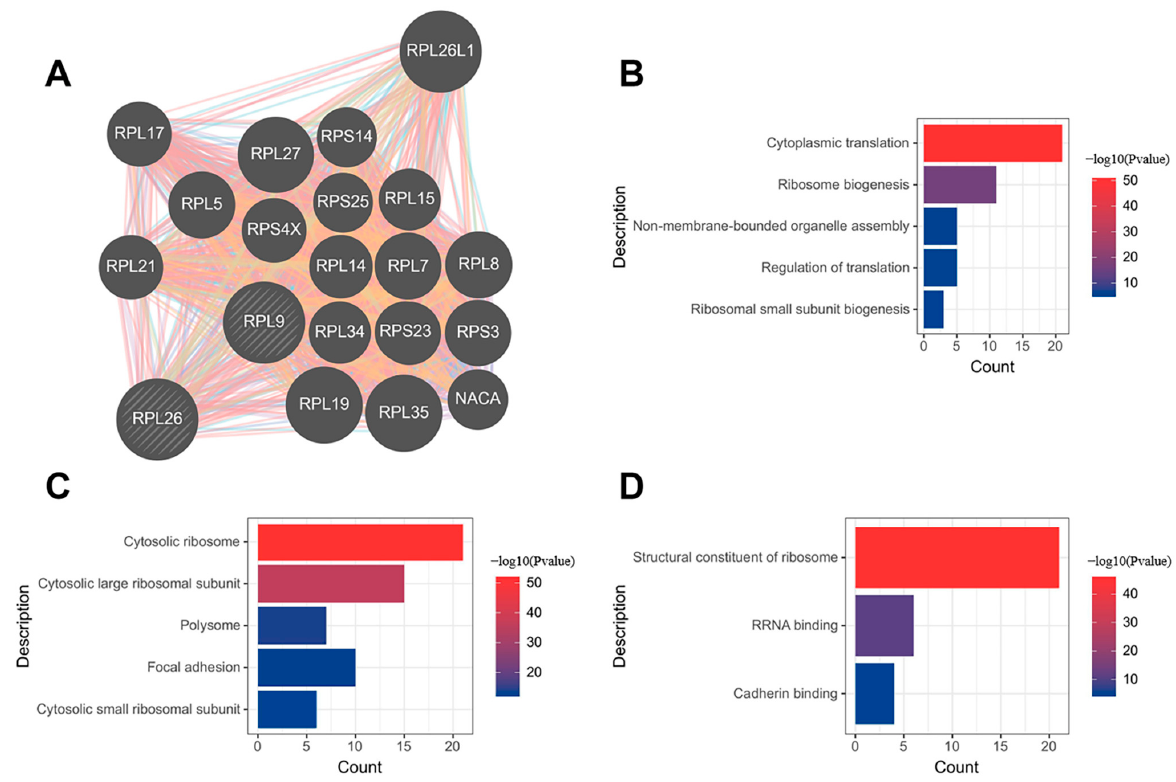
Figure 7. Putative RPL9 and RPL26 protein–protein interaction network and GO analysis. ( A ) PPI network. ( B ) Biological process. ( C ) Cellular component. ( D ) Molecular function. network. ( B ) Biological process. ( C ) Cellular component. ( D ) Molecular